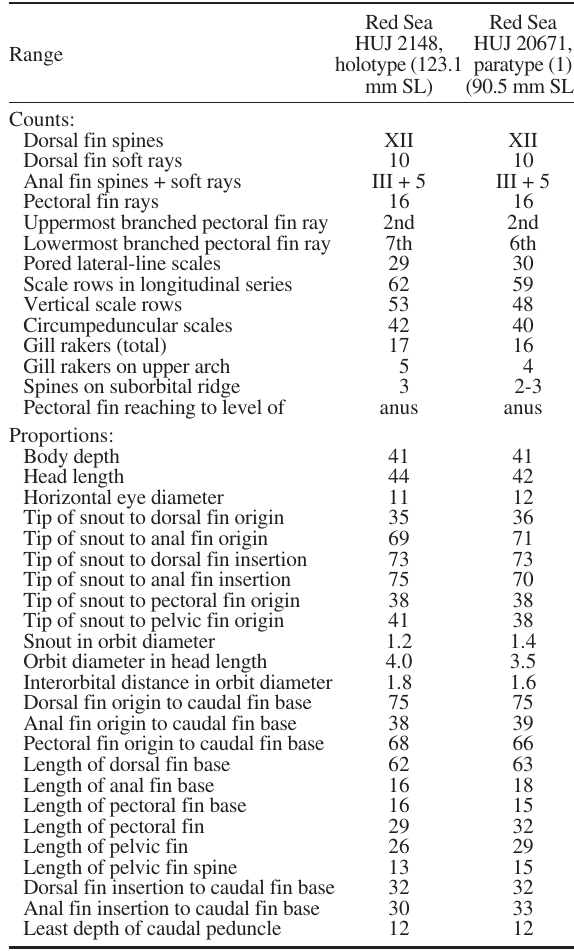
Table 1. – Selected counts and body proportions of Scorpaena decemradiata new species; proportions expressed as percentage of standard length unless otherwise